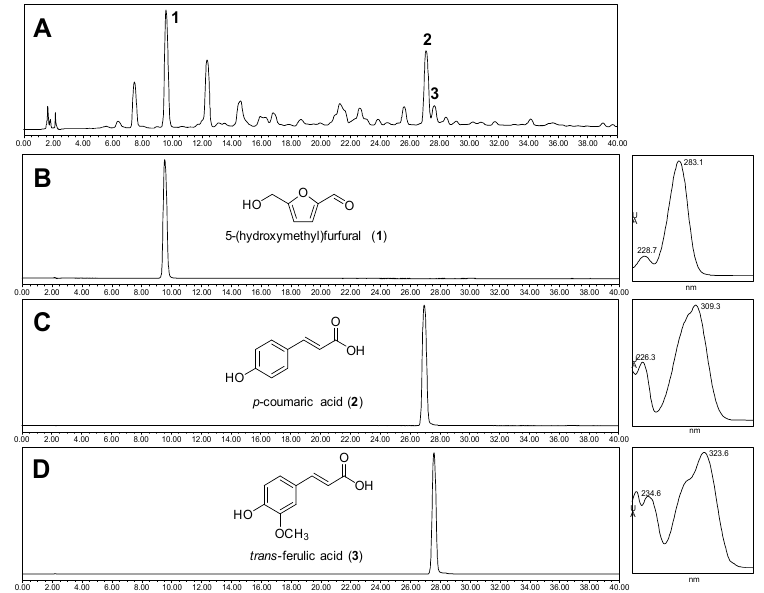
Figure 1. HPLC profiles for Salicornia europaea extracts (SE) and three reference compounds: 5-(hydroxymethyl)furfural (1); p -coumaric acid (2); and trans -ferulic acid (3). Chromatograms were extracted at 305 nm. ( A ) chromatograms of SE; and ( B – D ) HPLC profile and UV spectra of 5-(hydroxymethyl)furfural (1); p -coumaric acid (2); and trans -ferulic acid (3).